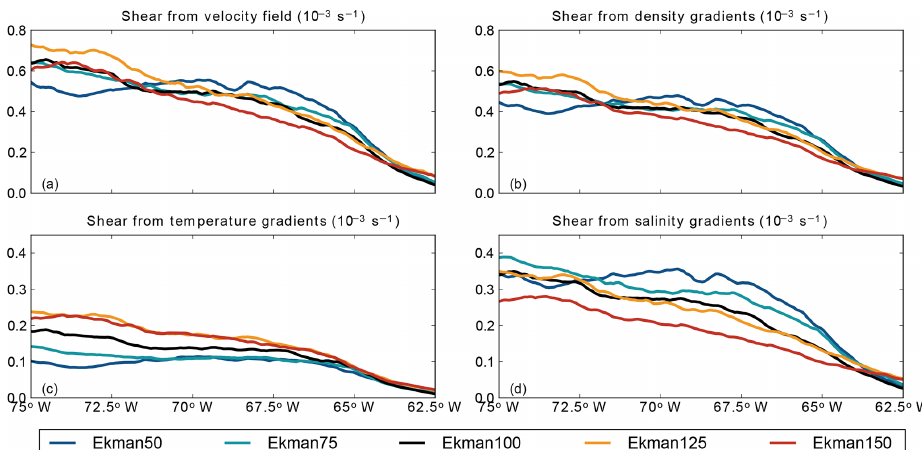
Figure 13. Zonal variation of the meridional average (12.5–17.5 ◦ N) of the (a) average vertical shear of the anticyclones, (b) horizontal density gradients, (c) horizontal density gradients induced by temperature gradients, and (d) horizontal density gradients induced by salinity gradients. All properties are computed over the upper 50m of the water